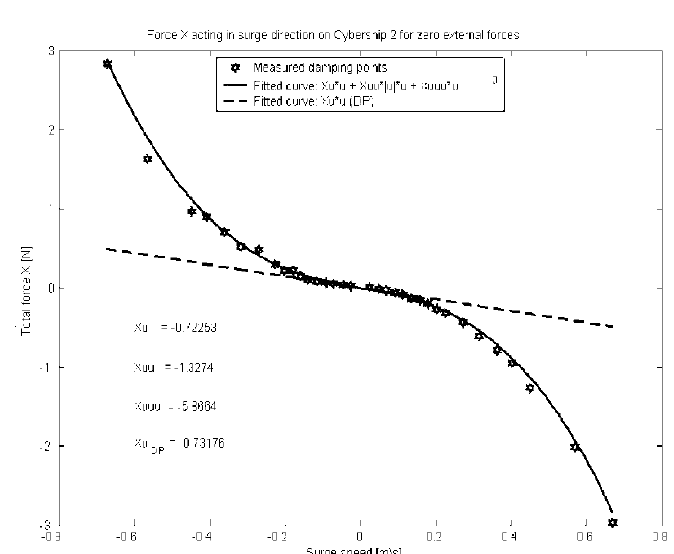
ó n ó 0 at di ff erent speeds and the 1 2